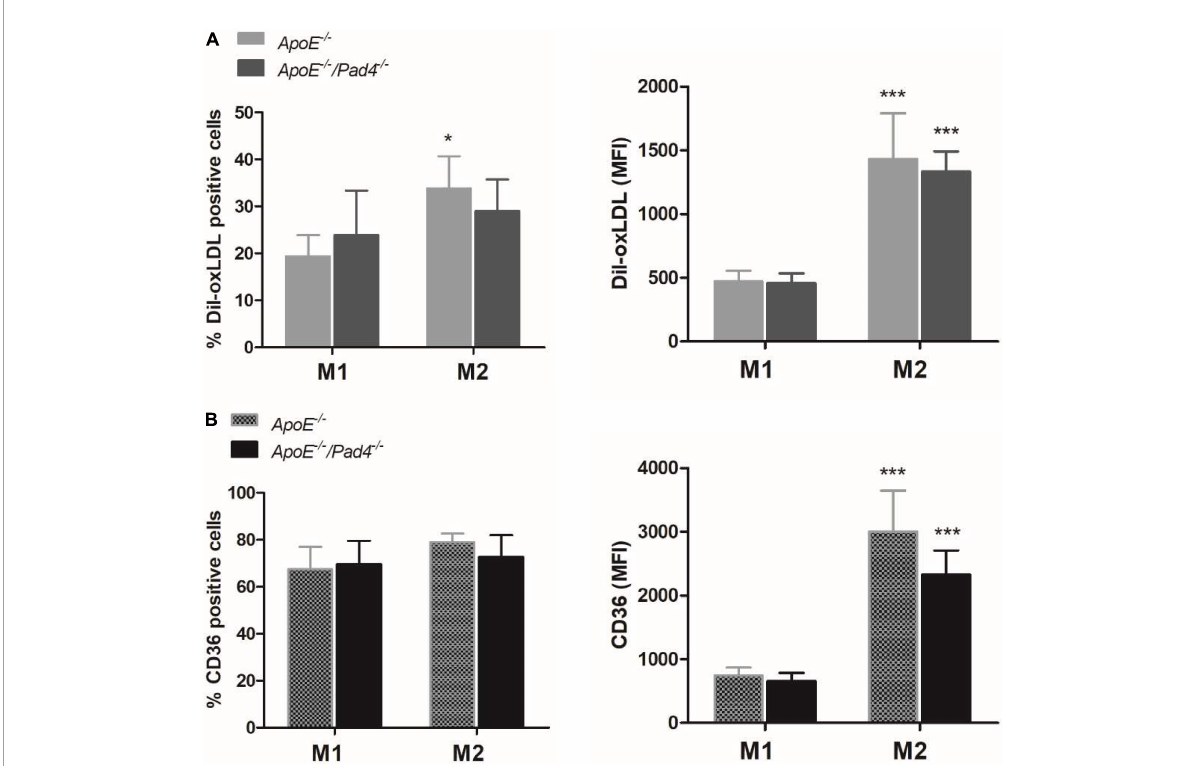
FIGURE3 oxLDL incorporation by polarized ApoE − / − and ApoE − / − /Pad4 − / − macrophages in vitro. Bone marrow-derived macrophages were polarized in vitro with 20 ng/mL IFN- γ and 100 ng/mL LPS or IL-4 to induce a M1- or M2a-like phenotype, respectively. (A) Cells were further incubated with Dil-labeled oxLDL for 6 h and internalized oxLDL was quantified by flow cytometry. (B) The expression of the oxLDL receptor CD36 was analyzed in parallel. The percentage of positive cells as well median fluorescence value (MFI) are depicted. n = 5 * p < 0.05, *** p < 0.001 vs. M1-like